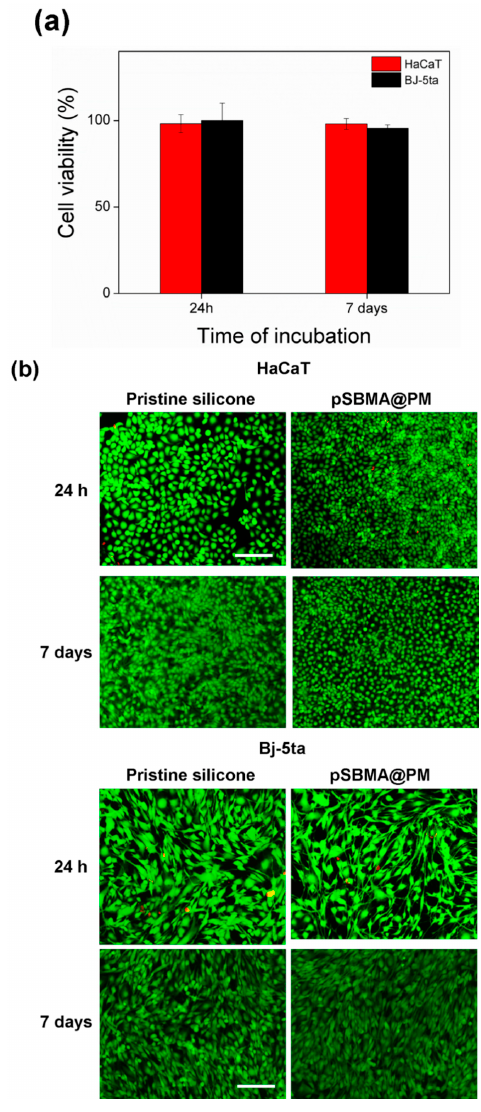
Figure 6 . Viability of HaCaT and BJ-5ta cell lines after exposure to the pSBMA@PM-coated silicones assessed by ( a ) AlamarBlue and ( b ) Live/Dead Kit assays. The green and red fluorescence images are overlaid. Scale bar corresponds to 100 µm.